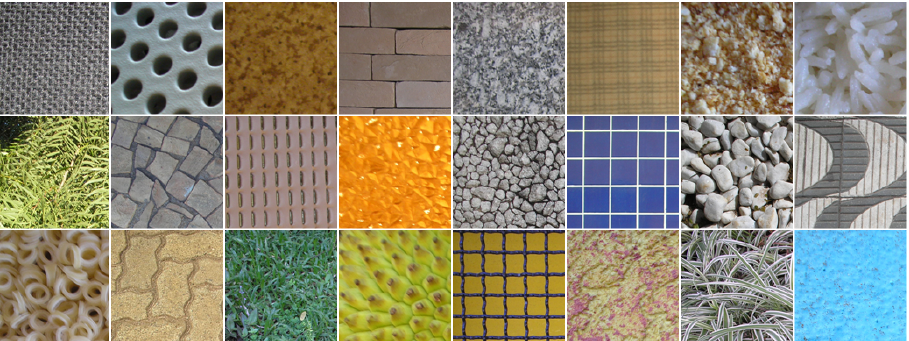
Figure 7. Samples of different categories from the USPtex dataset among the 191 color texture